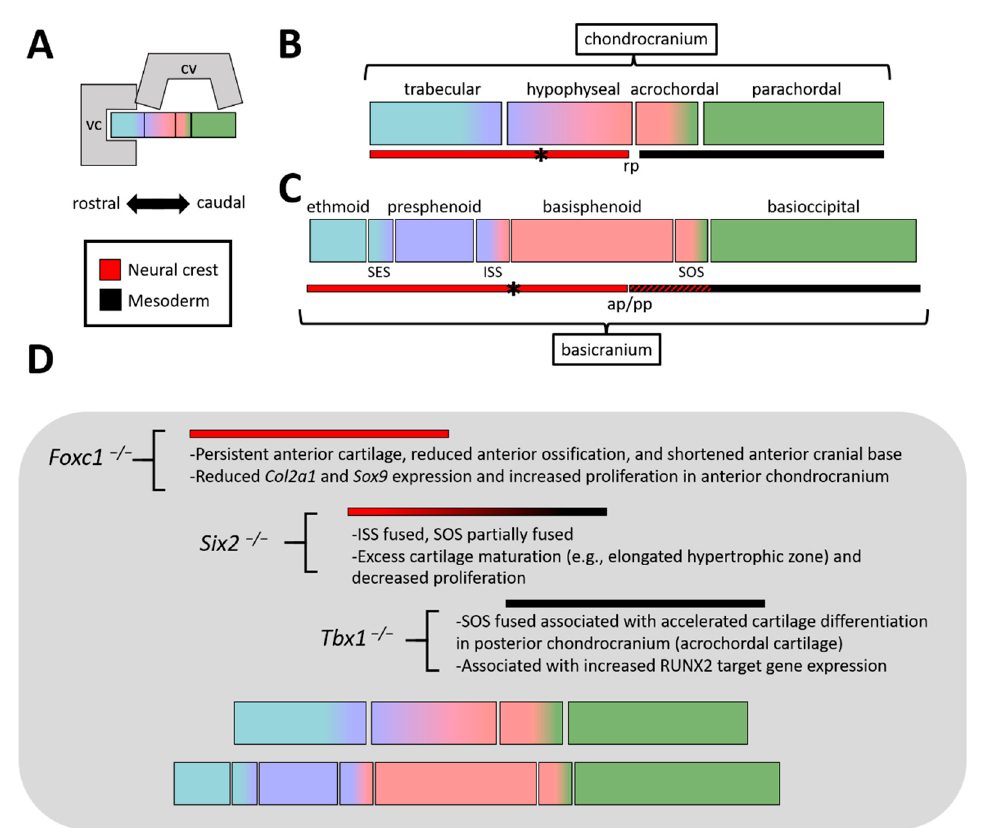
Figure 3. ( A ) ( Top ) Block schematic of viscerocranium, calvaria, and chondro/basicranium. ( Bottom ) Key for panels B, C, and D, highlighting orientation of rostral-caudal axis and neural crest—mesoderm color scheme. ( B ) Basic diagram of chondrocranial elements (along a midsagittal plane), highlighting the crisp neural crest—mesoderm interface at Rathke’s pouch (rp). The exception to this boundary is the hypochiasmatic cartilages (denoted by asterisk), which are mesoderm derived. ( C ) Same as B, but highlighting elements found within the basicranium (similar to Figure 2, just schematized). Note, the shades of blue are meant to provide a relative reference to their chondrocranial precursors, although boundaries are not meant to be exact. Also highlighted are the synchondroses (e.g., SES, ISS, SOS). The neural crest—mesoderm interface is found near the anterior-posterior pituitary (ap/pp), although this interface is substantially intermixed (indicated by red/black hash) within the basicranium. ( D ) Summary of the phenotypes in the 3 loss-of-function models covered in this review and where defects are located relative to the cranial base. Abbreviations: ap, anterior pituitary; cv, calvaria; ISS, inter-sphenoid synchondrosis; pp, posterior pituitary; rp, Rathke’s pouch; SOS, spheno-occipital synchondrosis; vc,